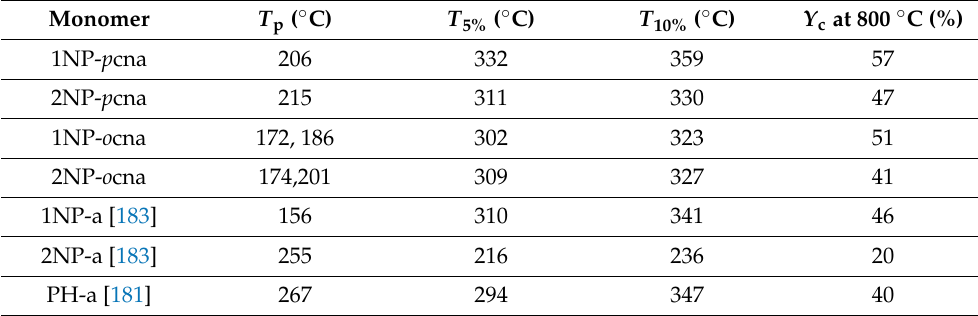
Table 2. Thermal characterization of naphthoxazine and general benzoxazine